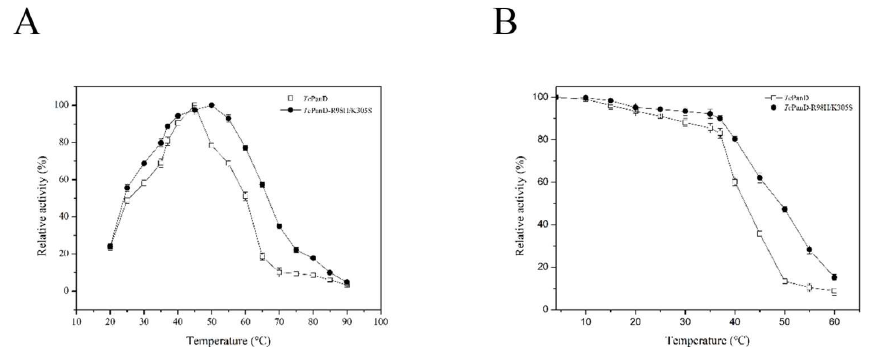
Figure 4. E ff ect of temperature on TcPanD and TcPanD-R98H / K305S ( A ) and thermostability ( B ). Figure 4. Effect of temperature on TcPanD and TcPanD-R98H/K305S ( A ) and thermostability ( B ). A, A, The optimal temperature of TcPanD and TcPanD-R98H / K305S; B, The thermal stability of The optimal temperature of TcPanD and TcPanD-R98H/K305S; B, The thermal stability of TcPanD and TcPanD-R98H/K305S at different temperatures (4–60 °C). Data are given as mean ± SD, n = 3.